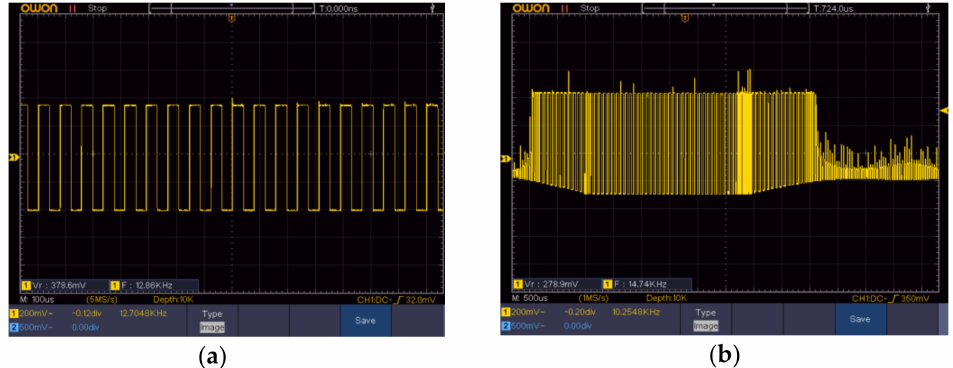
Figure 16. Samples from the generator with IC NE555P: ( a ) not exposed to EMP; ( b ) exposed to EMP.